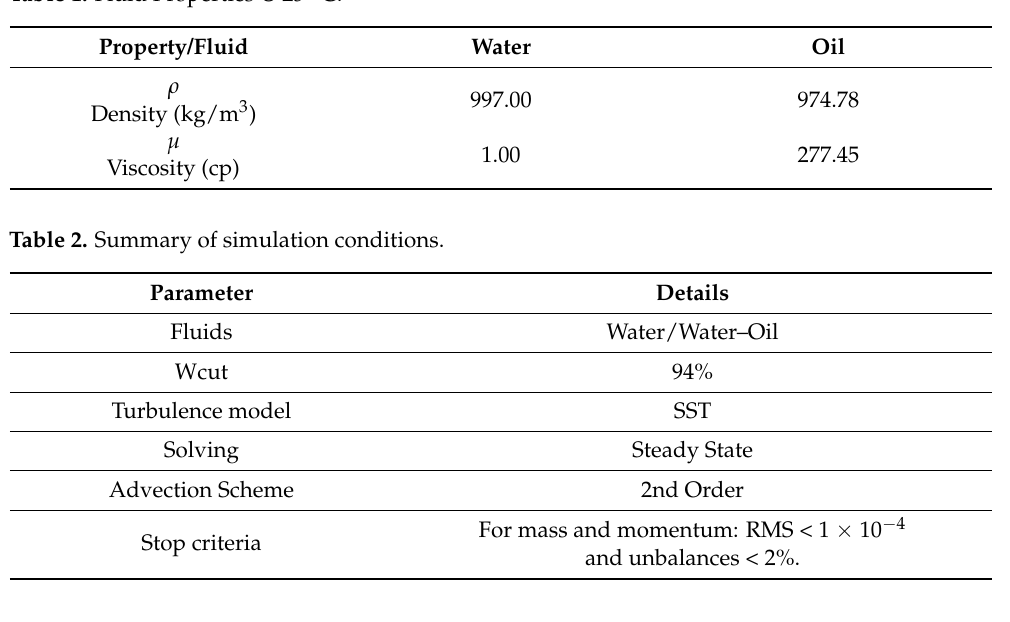
Table 1. Fluid Properties @ 25 ◦ C.